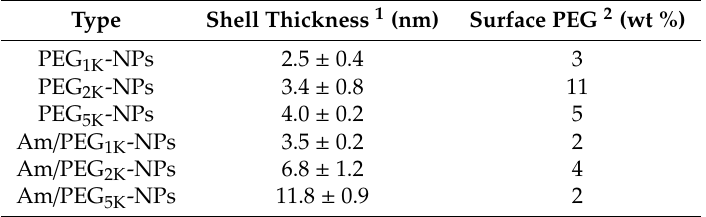
Table 2. Shell thickness of NPs and percentage of PEG on NPs